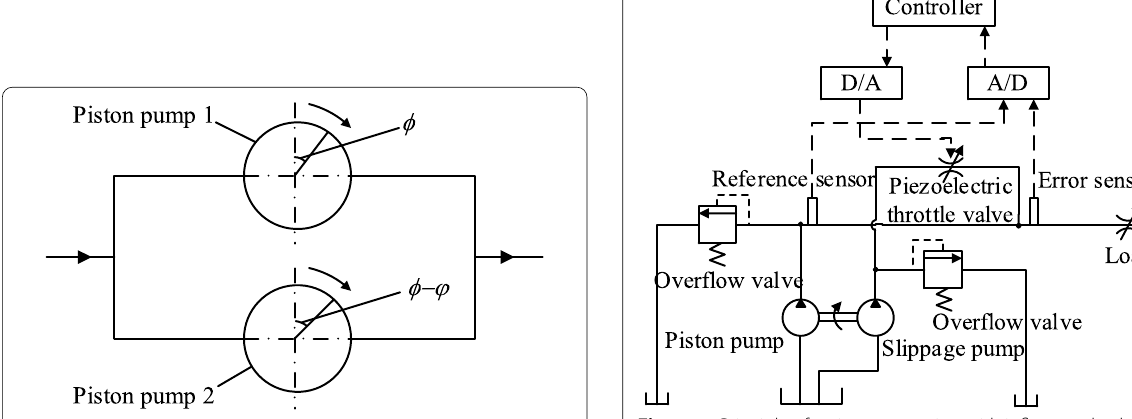
Figure 3 Principle of staggered phase parallel piston pump Figure 5 Principle of active suppression with inflow